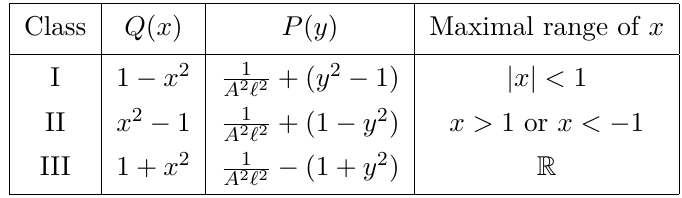
Table 2 . The metric functions in canonical gauge, together with the largest available range of x